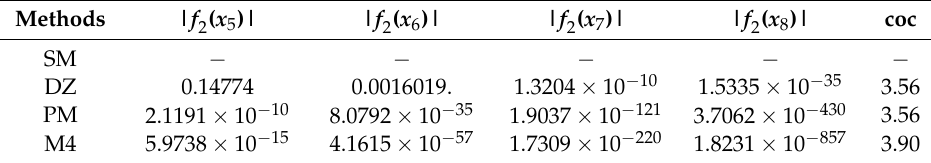
Table 2. Result of comparisons for the function f 2 .